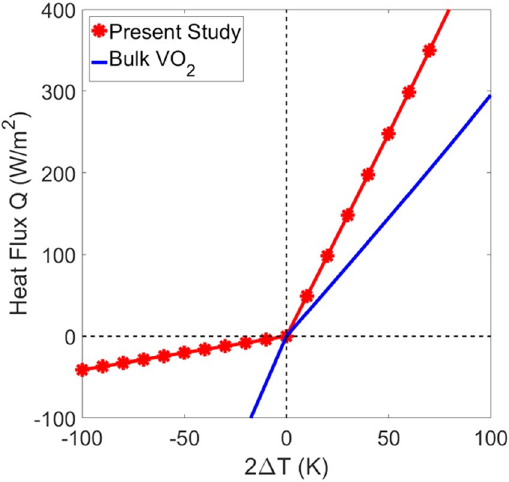
Figure 3. Heat flux plotted against temperature difference for thermal diode with bulk VO 2 and present